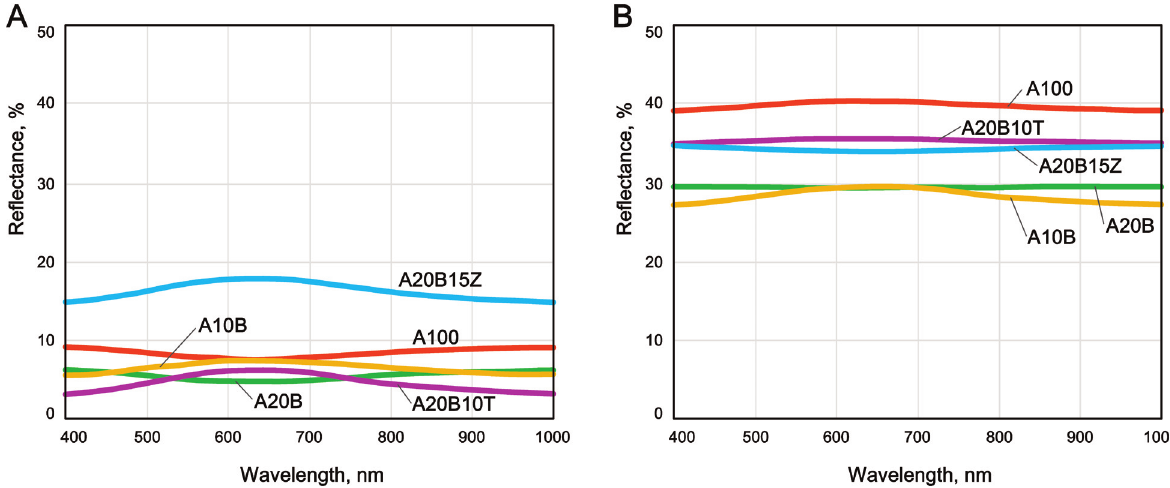
Fig. 3. Spectral signature of the cutting tool materials (A) and spectral signature of the steel workpiece taken after the cutting test (B) in the range of 400–1000 nm.